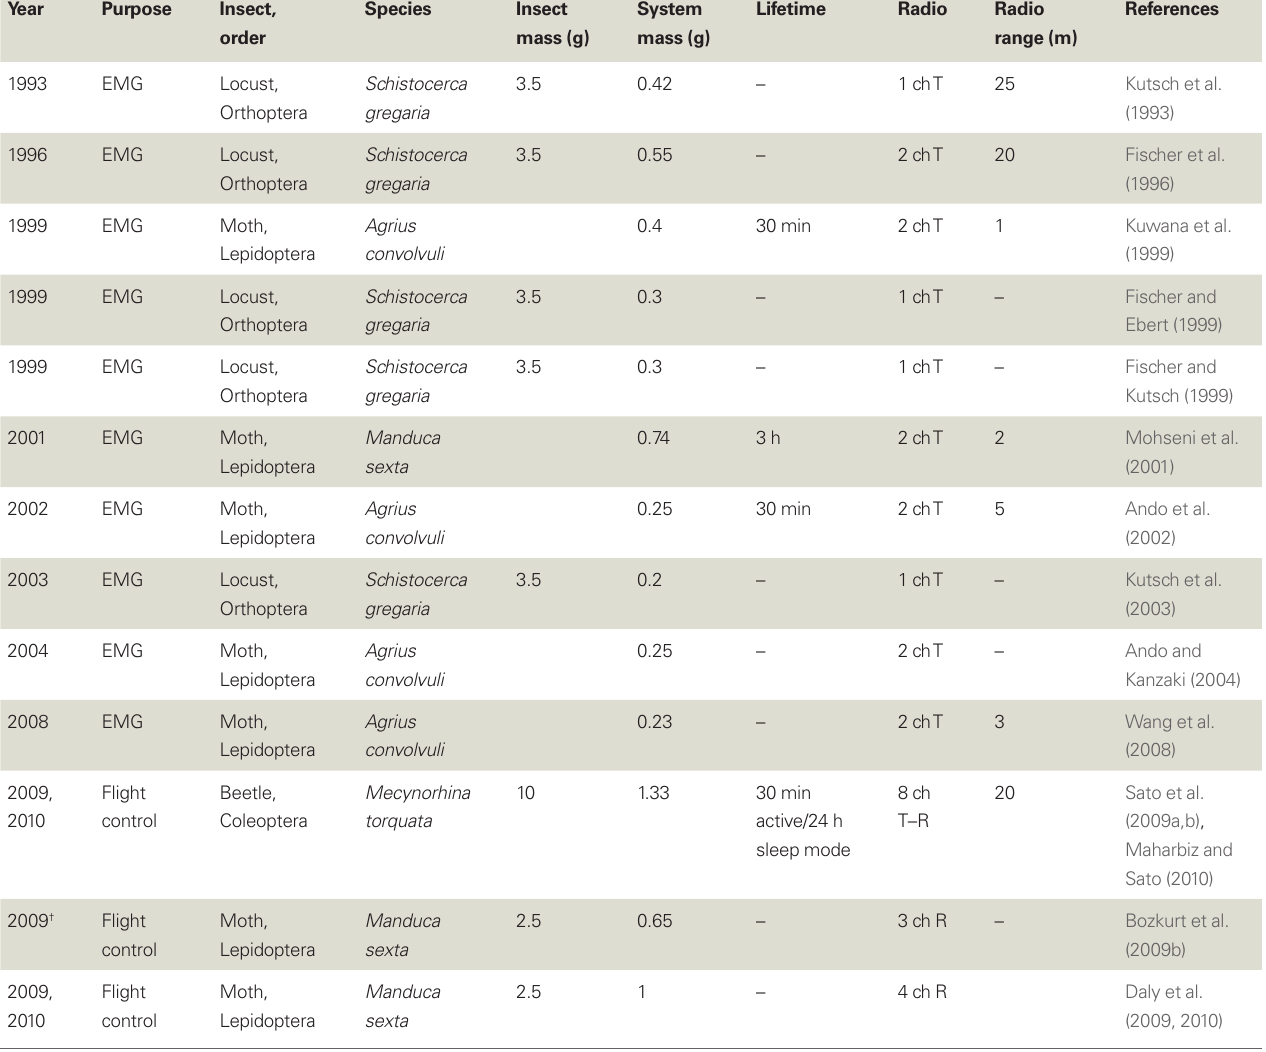
Table 1 | Representative systems used for neuromuscular recording and/or stimulation of free-flying